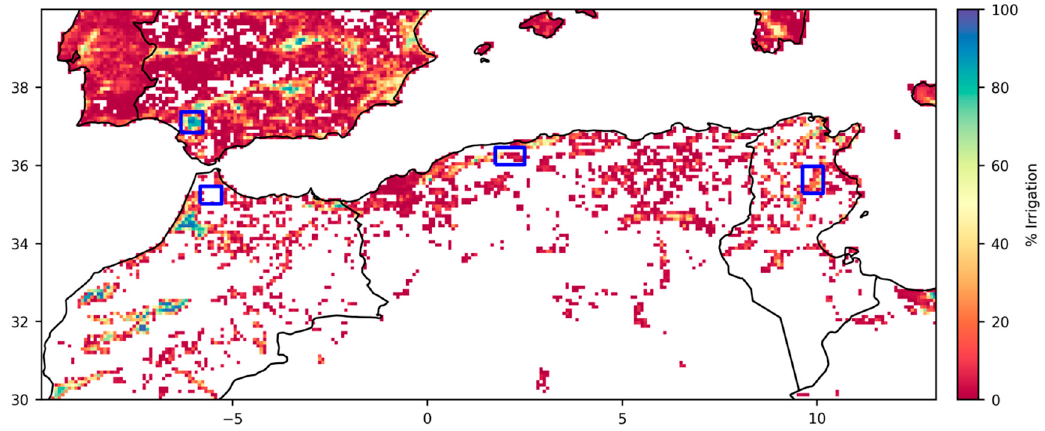
Figure 2. The percentage of irrigated area according to Siebert et al. [47].